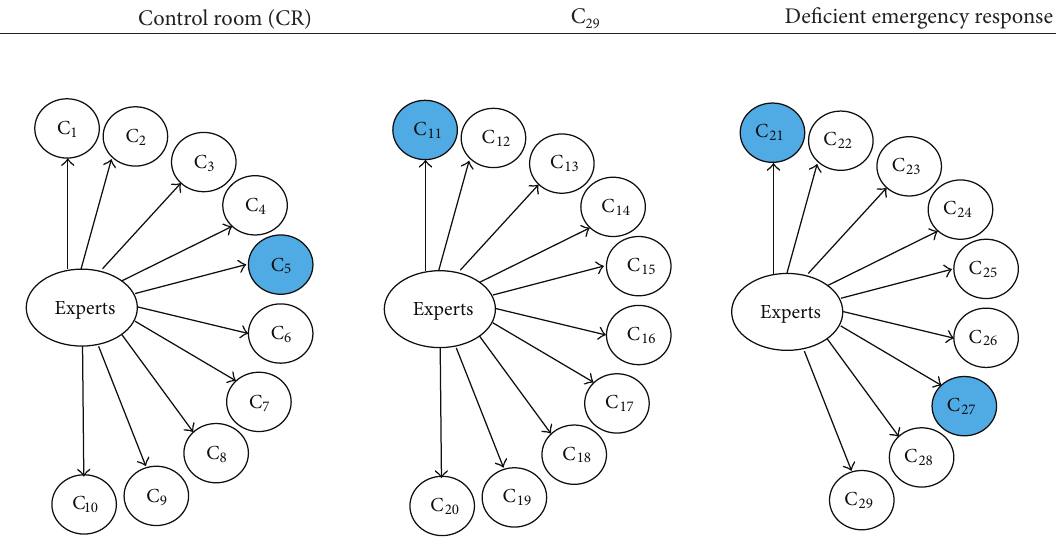
Figure 6: Selection of precursor by using